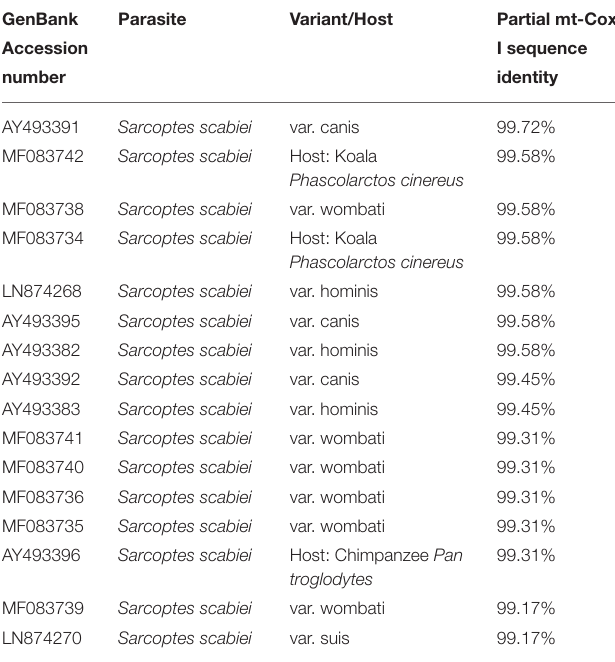
TABLE 1 | Nucleotide BLAST results of the partial mitochondrial cytochrome c oxidase subunit I product from this study.